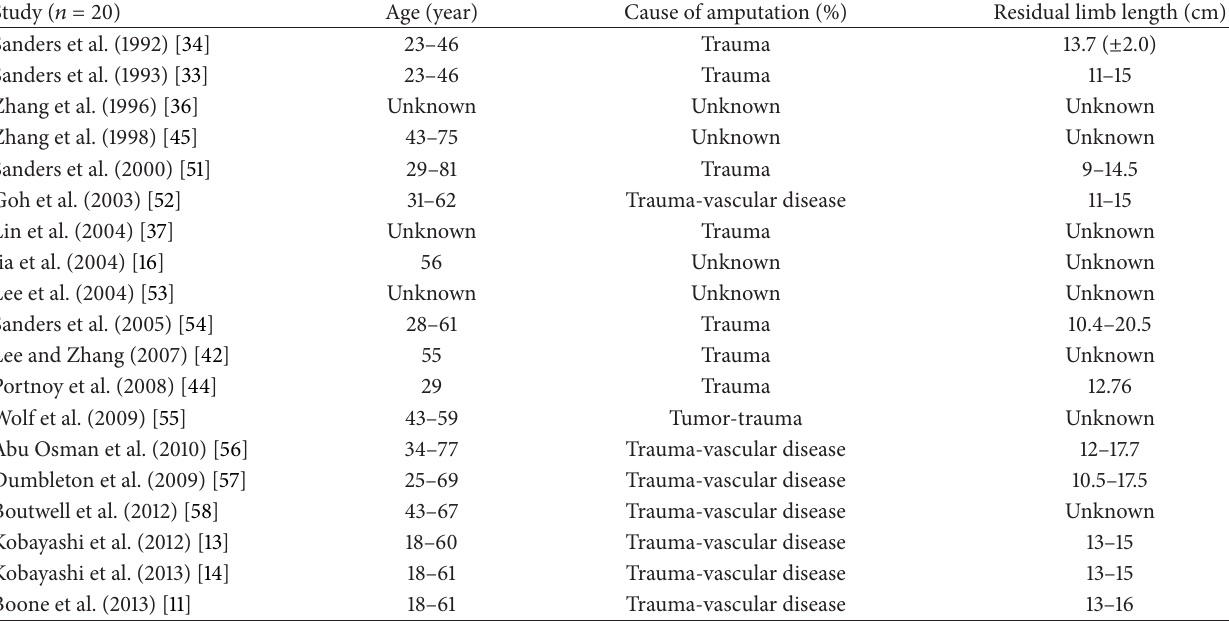
Table 1: Characteristics of subjects in the studied